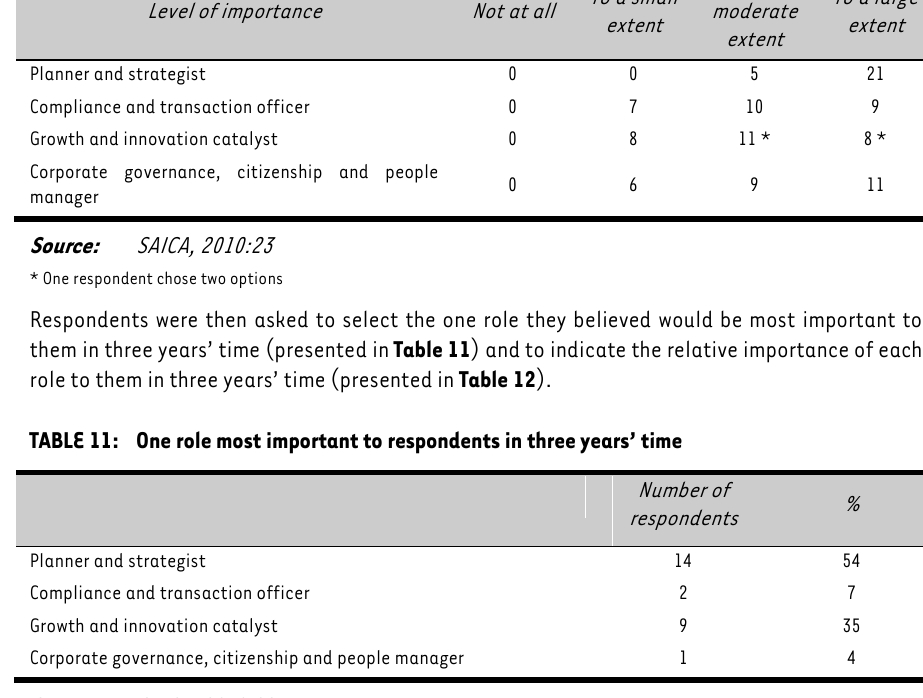
To a To a small To a large moderate extent extent extent